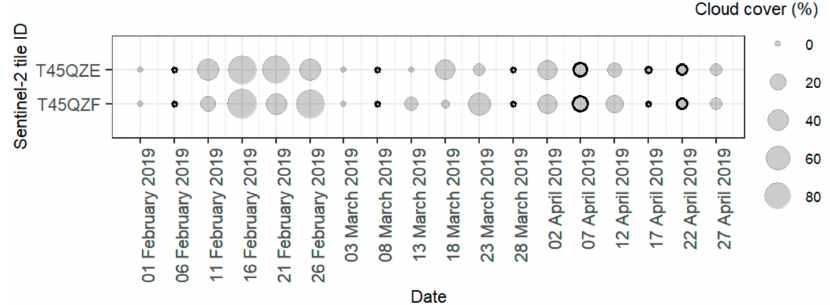
Figure 3. Availability of Sentinel-2 images acquired during the mung bean growing season from February 6 through April 22 of 2019 over the study area. Images marked with a black bold circle were used for the